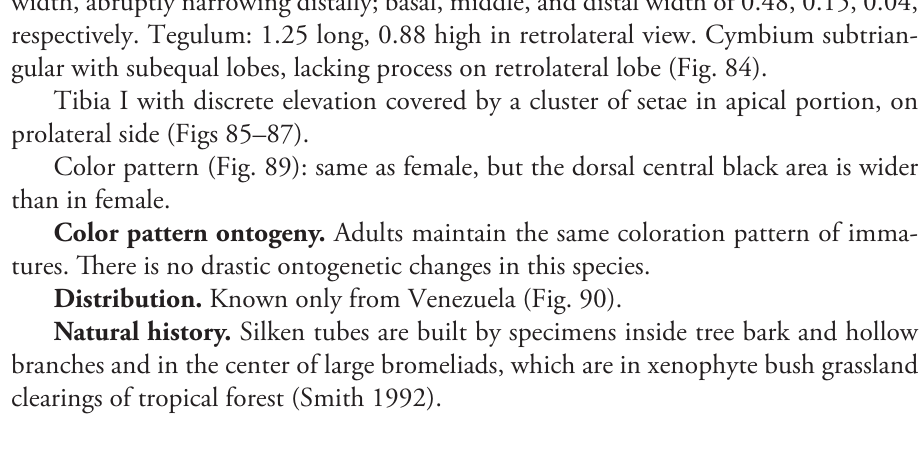
width, abruptly narrowing distally; basal, middle, and distal width of 0.48, 0.15, 0.04, respectively. Tegulum: 1.25 long, 0.88 high in retrolateral view. Cymbium subtrian-